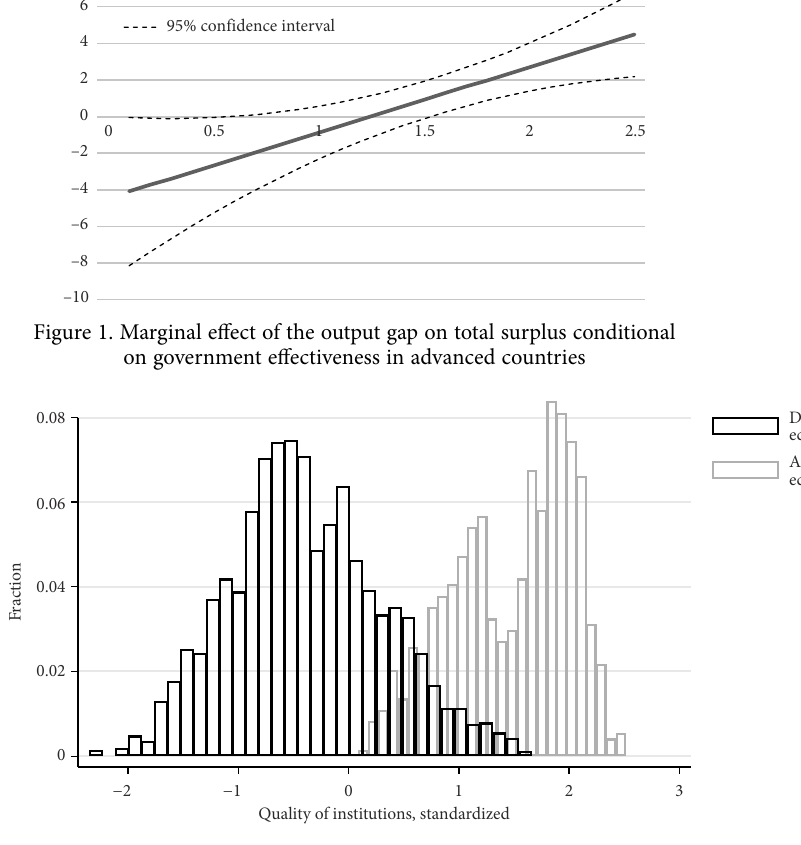
Figure 2. Distribution of the standardized indicator of institutional quality